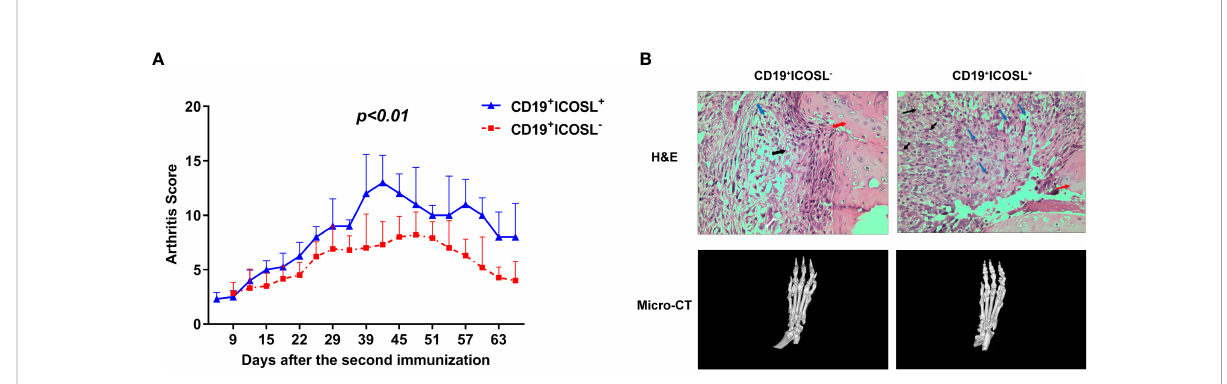
FIGURE 5 Adoptive transfer in CIA mice. (A) CIA mice were adoptively transferred with ICOSL - CD19 + B cells and CD19 + ICOSL + B cells. Transfer of CD19 + ICOSL + B cells aggravated arthritic progression. (B) H&E histological stains (×400 original magni fi cation) and micro-computed tomographic analysis of representative ankle sections in the adoptive transfer experiments. In H&E staining, key points were marked with arrows of different colors: blue arrows for in fi ltrating immune cells, black arrows for pannus and red arrows for